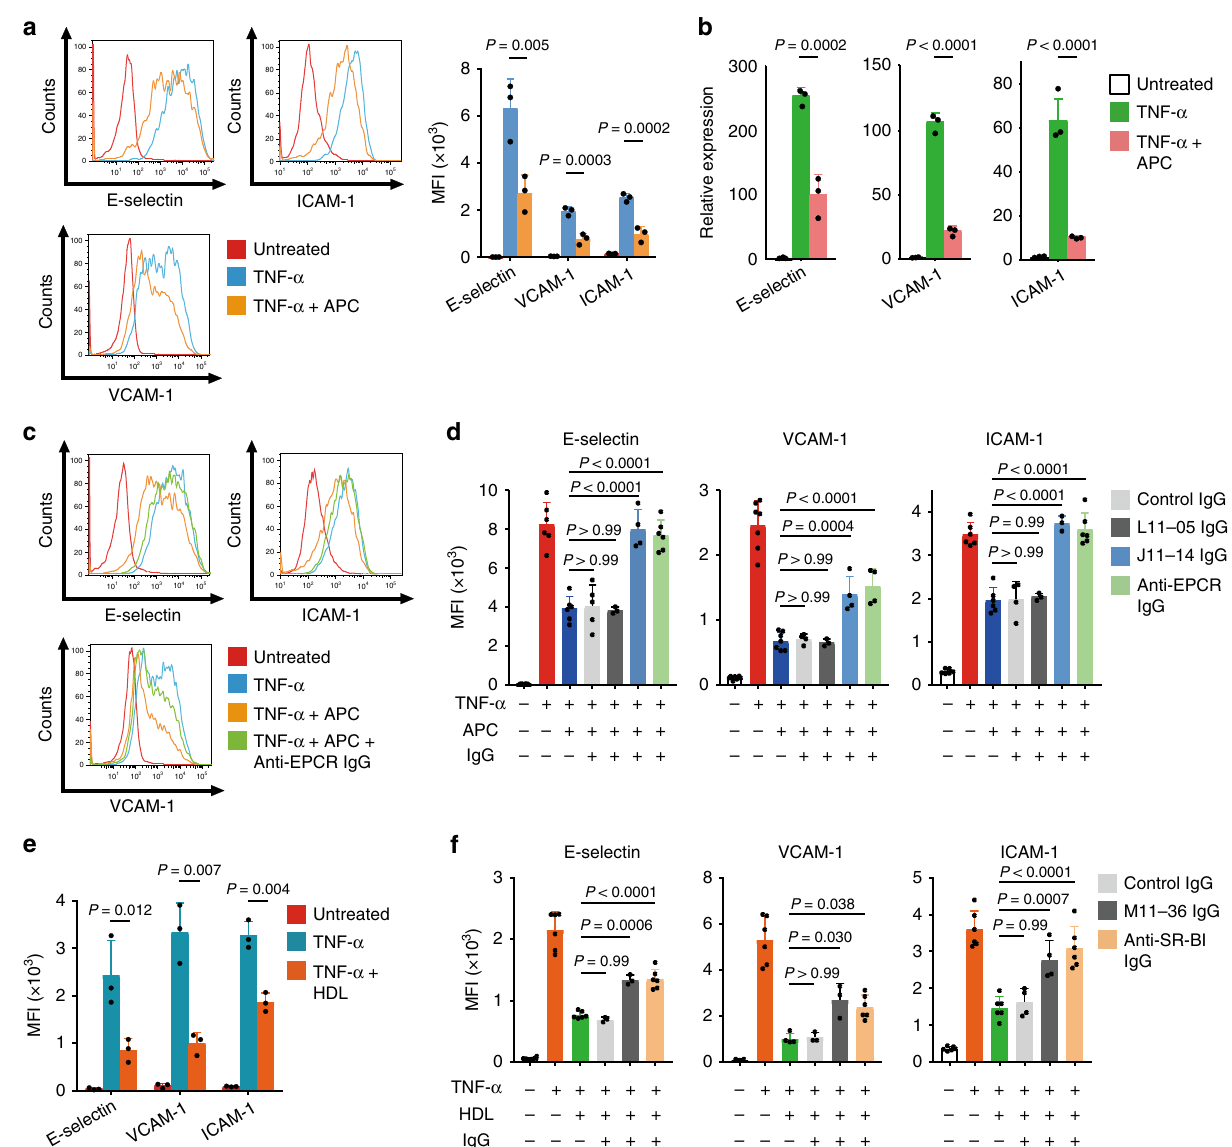
Fig. 5 Blocking of anti-in fl ammatory activities of EPCR and SR-BI by autoantibodies in Takayasu arteritis. a , b HUVECs were treated with or without 10 µ g/mL APC for 13 h and stimulated with 100 pg/mL TNF- α for 5 h. The expression of adhesion molecules, including E-selectin, VCAM-1, and ICAM-1, was analyzed with fl ow cytometry. Representative histograms (left) and the summary graph (right, n = 3) are shown in a . The mRNA expression level was measured by quantitative PCR in b . GAPDH was used as the internal control. c HUVECs were incubated with the isotype or 10 µ g/mL anti-EPCR antibody for 1 h and treated with or without 10 µ g/mL APC for 13 h. Then, cells were stimulated with 100 pg/mL TNF- α for 5 h. The expression of adhesion molecules was analyzed with fl ow cytometry. d HUVECs were incubated with or without IgG for 1 h. IgG included 10 µ g/mL anti-EPCR antibody, 2.56 mg/mL control IgG, 2.56 mg/mL IgG from an AECA-negative TAK sample (L11-05), or 2.56 mg/mL IgG from anti-EPCR-positive TAK AECA sample (J11-14). The cells were subsequently treated as described above, and the expression of adhesion molecules was analyzed. e HUVECs were treated with or without 1 mg/mL high-density lipoprotein (HDL) for 16 h and stimulated with 100 pg/mL TNF- α for 5 h. Adhesion molecules were analyzed by fl ow cytometry; the summary graph is shown ( n = 5). f HUVECs were incubated with or without IgG for 1 h. IgG included 10 µ g/mL anti-SR-BI antibody, 2.56 mg/mL control IgG, or 2.56 mg/mL IgG from anti-SR-BI positive TAK AECAs (M11-36). Cells were subsequently treated with or without 1 mg/mL of HDL as described above, and adhesion molecules were analyzed ( n = 3). Data are indicated as mean ± SD. At least three independent experiments were performed in all cases. Statistical analysis was performed using one-way ANOVA followed by Tukey ’ s post hoc test. MFI represents mean fl uorescent intensity. L11-05, J11-14, and M11-36 indicate the serum sample